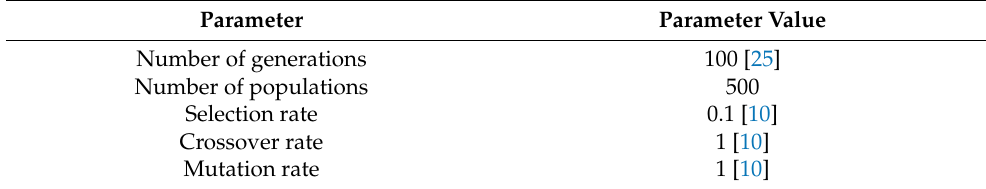
Table 4. List of GA parameters used in Logic